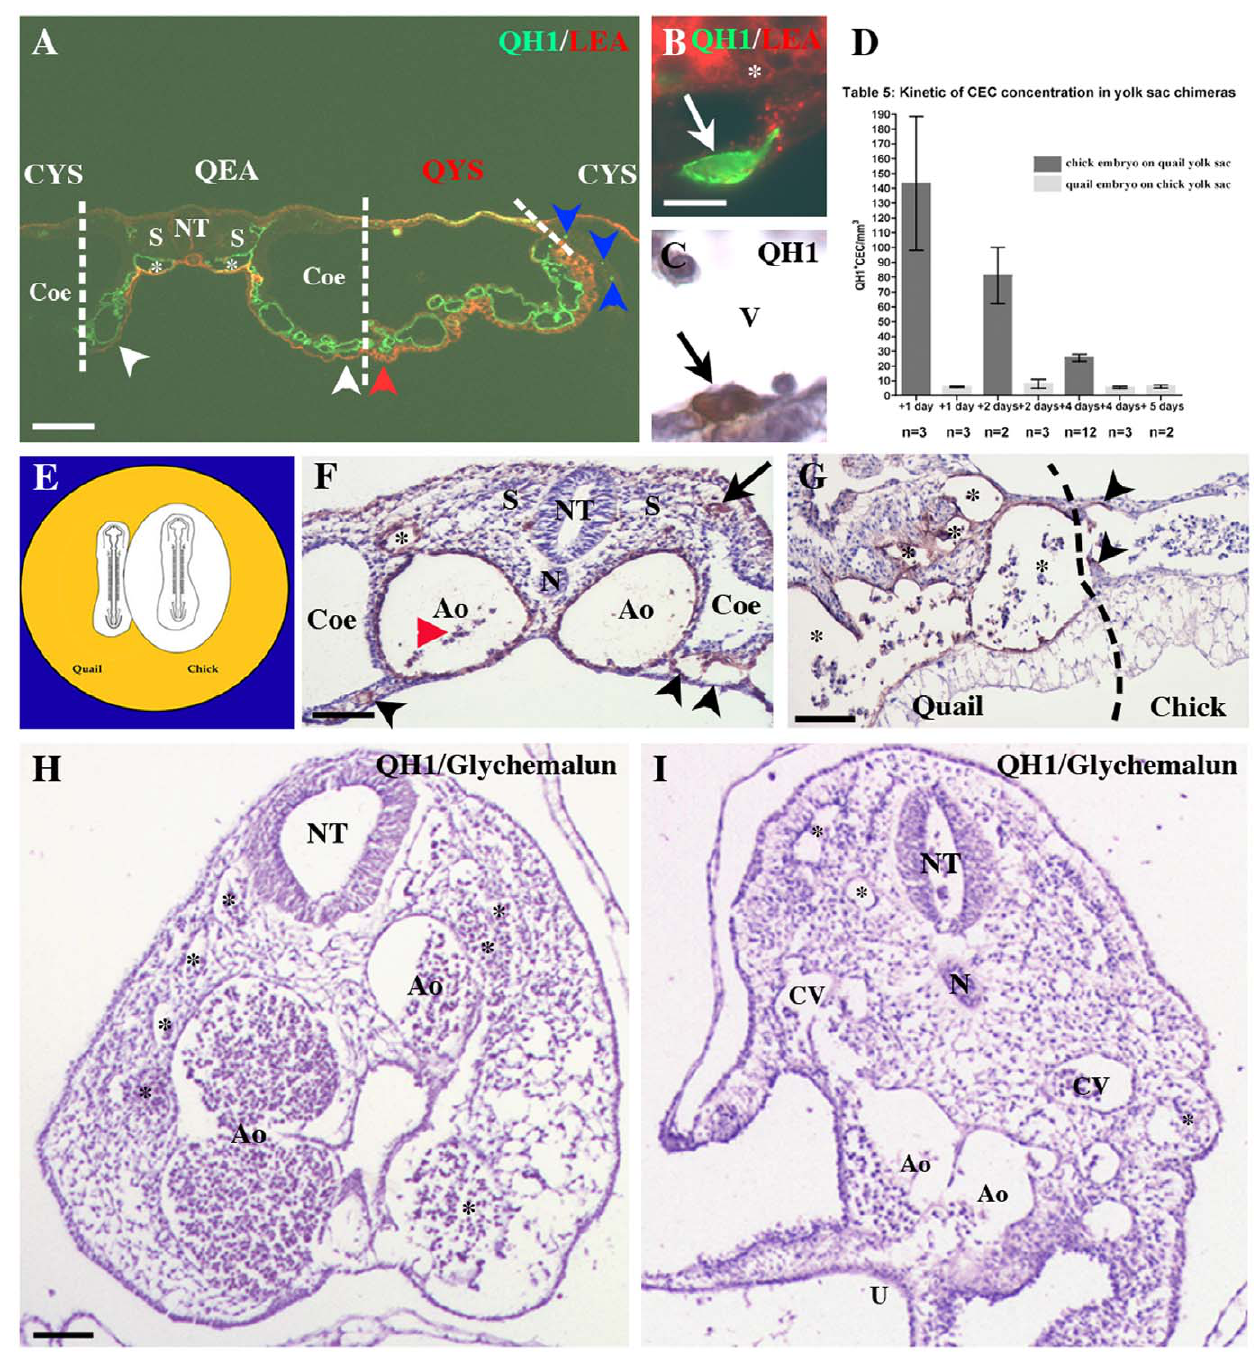
Figure 5. Absence of embryo-derived CEC. A) Transverse section through the trunk of a yolk sac chimera (quail embryo/chick yolk sac) one day after the operation. On the right, the grafted quail territory in which all the vessels are QH1 + (green) includes the embryonic area (QEA) and a part of the quail yolk sac (QYS). The distinction between the two regions is histologically possible comparing their respective unspecific LEA-stained endoderm: the endoderm of the embryonic area (white arrowheads) is thinner than the yolk sac endoderm (red arrowhead). On both sides, the quail tissues are well associated with the chick yolk sac (CYS). The blue arrowheads point to three isolated QH1 + cells migrating in chick yolk sac vessels. Coe: coelom; NT: neural tube; S: somite; *: aorta. Bar: 110 mm. B) A QH1 + /LEA 2 CEC (arrow) interstitially migrates at the surface of the chick yolk sac endoderm (*). C) A QH1 + CEC (arrow) reaches the endothelium of a yolk sac vessel (V). Bar: 20 mm in B and C. D) Table 5: Comparison of CEC number in quail yolk sac-chick embryo chimeras (dark gray) and chick yolk sac quail embryo chimeras (clear gray). This histogram shows that in the combination chick yolk sac/quail embryo this number is constant and residual (clear gray) by comparison with CEC concentration in the opposite combination (dark gray). E) Scheme of the in vitro quail-chick chimera procedure: on a semi-solid medium (orange) a quail embryonic territory, completely isolated from its yolk sac, and a whole chick blastoderm (embryonic + yolk sac areas) are placed side by side to permit the establishment of vascular connections. F–I) QH1 immunohistochemistry on transverse sections of in vitro chick-quail chimeras 1.5 day after the operation: F) The quail embryo is viable as shown by 1) chick blood cells (red arrowhead) in the aortae (Ao), which attested that a circulation is established with the